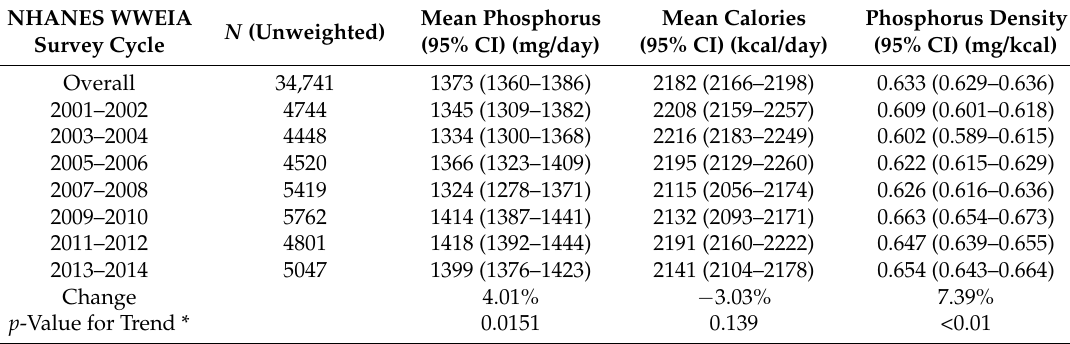
Table 1. Mean daily phosphorus and total calorie intake and phosphorus density (proportion of phosphorus of total calories) for U.S. adults 20 years of age or older and according to NHANES WWEIA survey